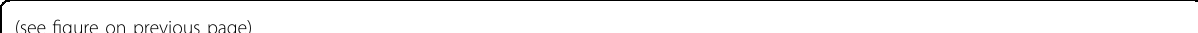
region, residues 509 – 552 of ATXN7 from the DUB module meanders through the core module and extends toward an extra EM density that is visible in low- resolution maps of hSAGA (Fig. 1d and Supplementary Figs. S4a, S5a). Comparison with yeast SAGA structure revealed that Sgf73, the yeast homolog of ATXN7, occu- pies the similar position as the ATXN7 fragment does in